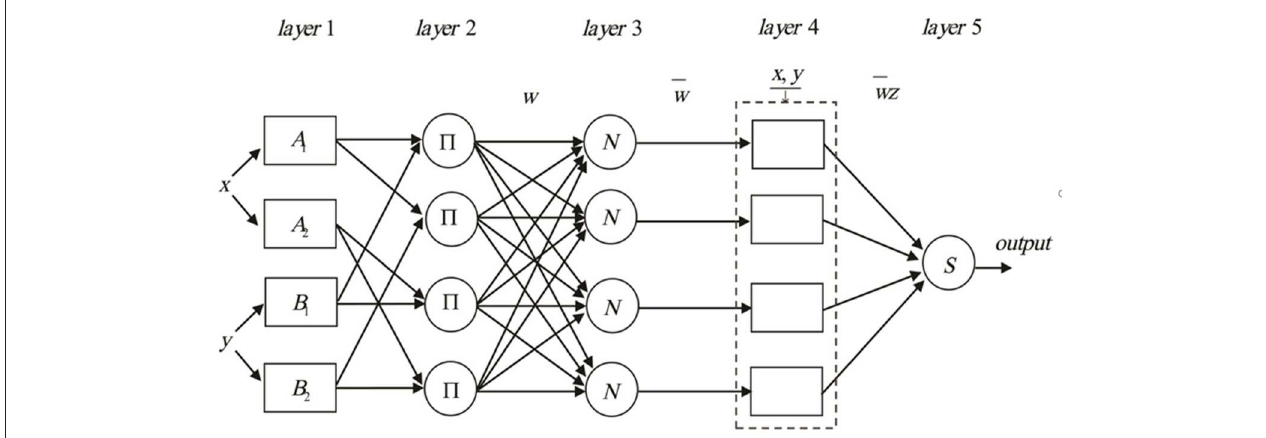
FIGURE 1 | The schematic diagram of the proposed ANFIS